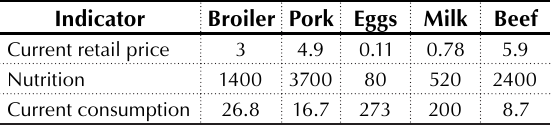
Table 1. Data to consumption optimization